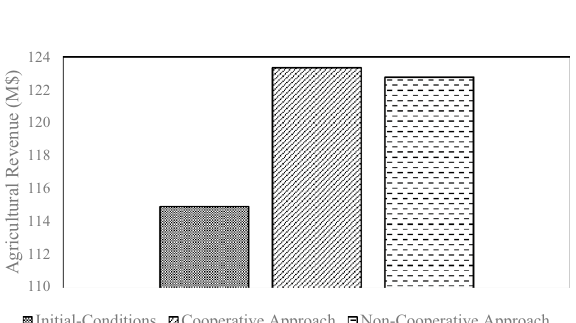
Figure 5. Average annual volume of water supply and demand calculated with the non-cooperative allocation approach (MCM = 10 6 m 3 ).